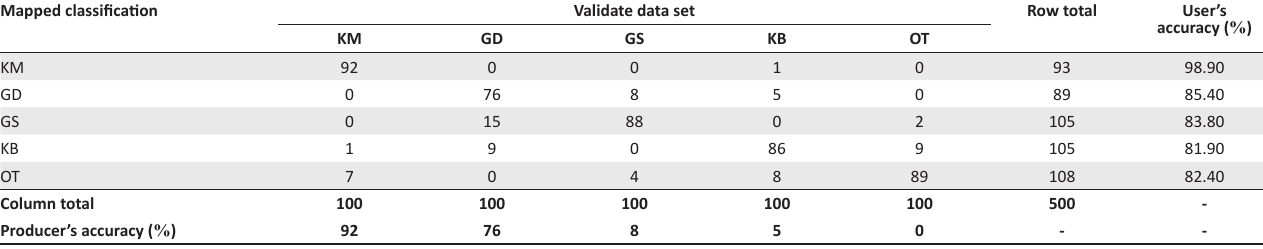
TABLE 1-A1: Accuracy assessment of the Landsat-based vegetation map for the Tswalu Kalahari Reserve using a confusion matrix. Mapped classification Validate data set Row total